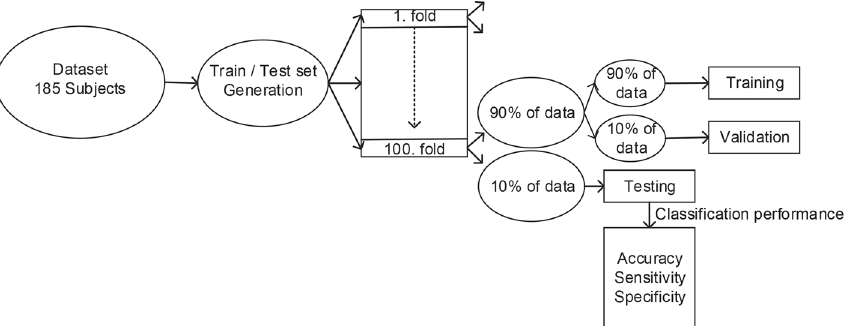
Figure 6. A block scheme of the training—testing process.